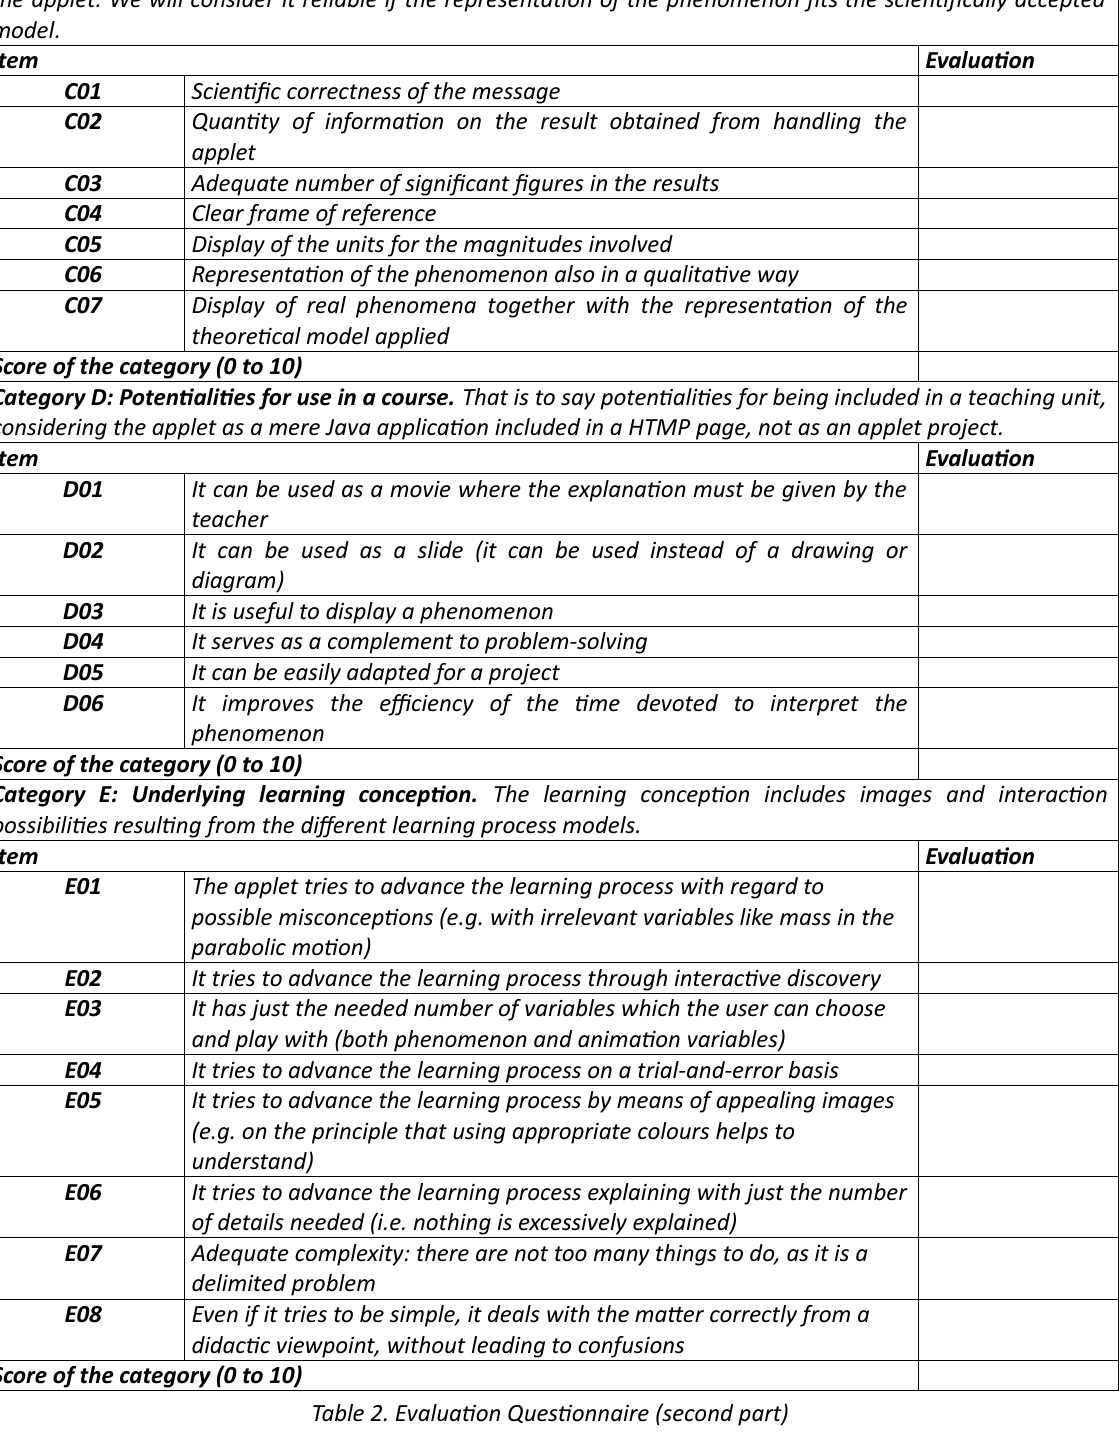
Table 2. Evaluation Questionnaire (second